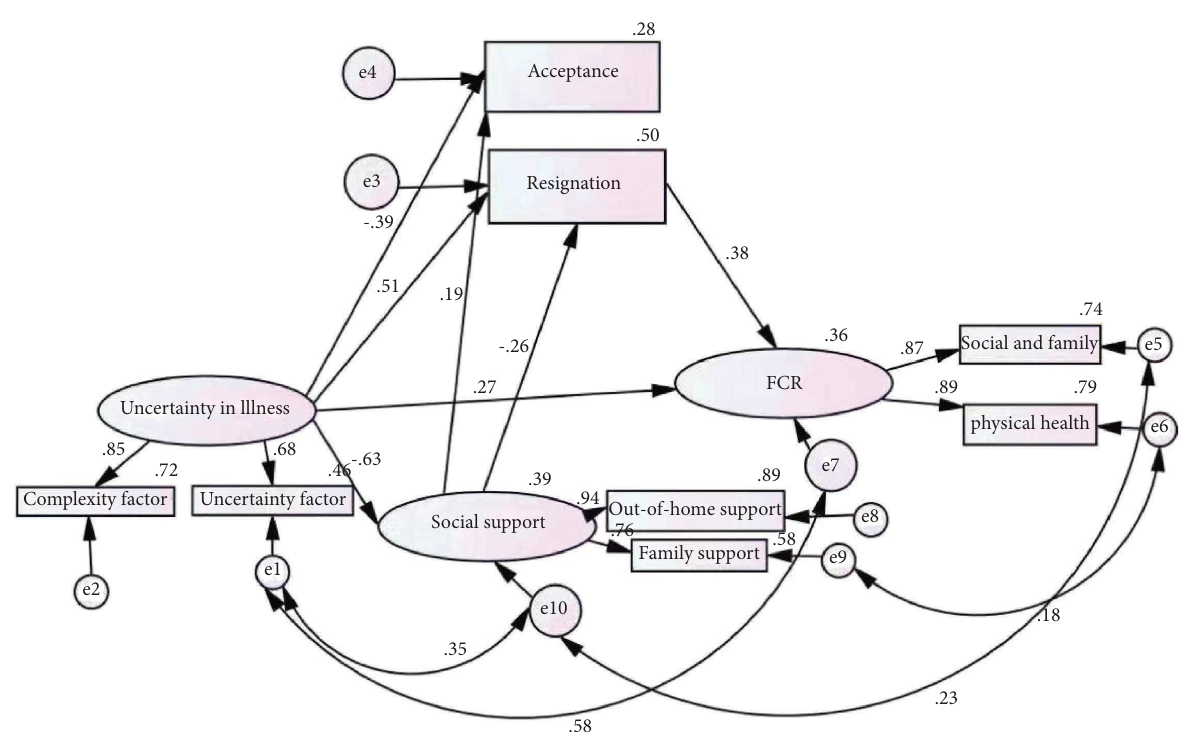
Figure 2: Modifed diagram of structural equation model of infuencing factors for FCR in breast cancer